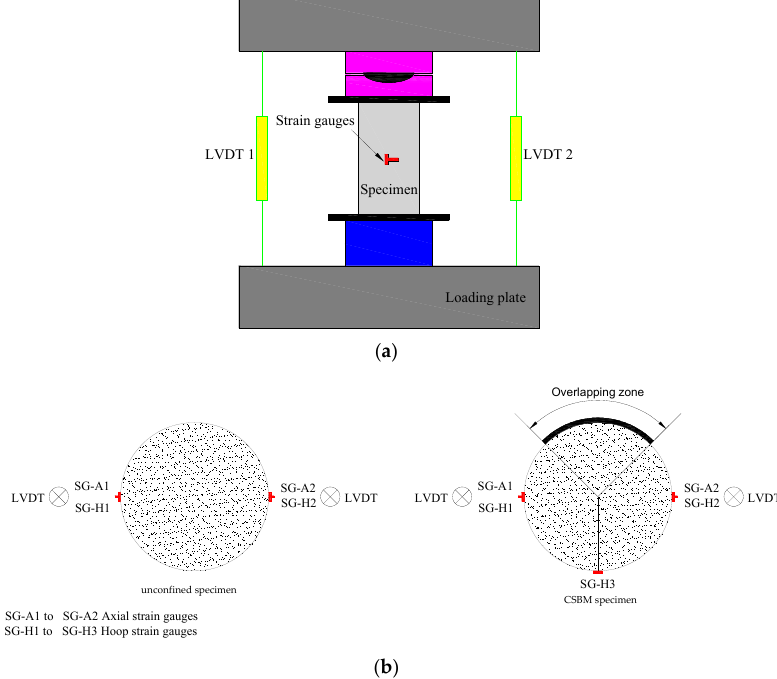
Figure 6. Test set-up ( a ) and layout of strain gauges and LVDTs ( b ). SG-A1 to SG-A2 represent axial strain gauges and SG-H1 to SG-H3 stand for hoop strain gauges.